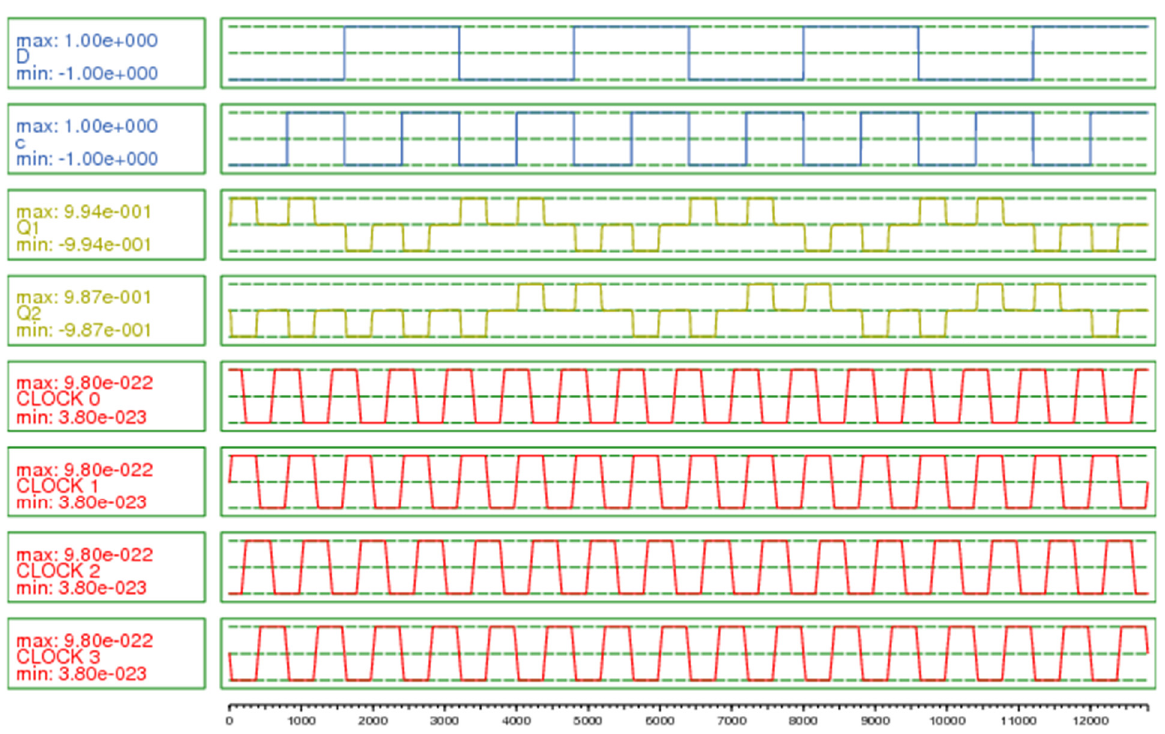
Figure 17. Simulation Graph of the 2-bit SIPO shift register.